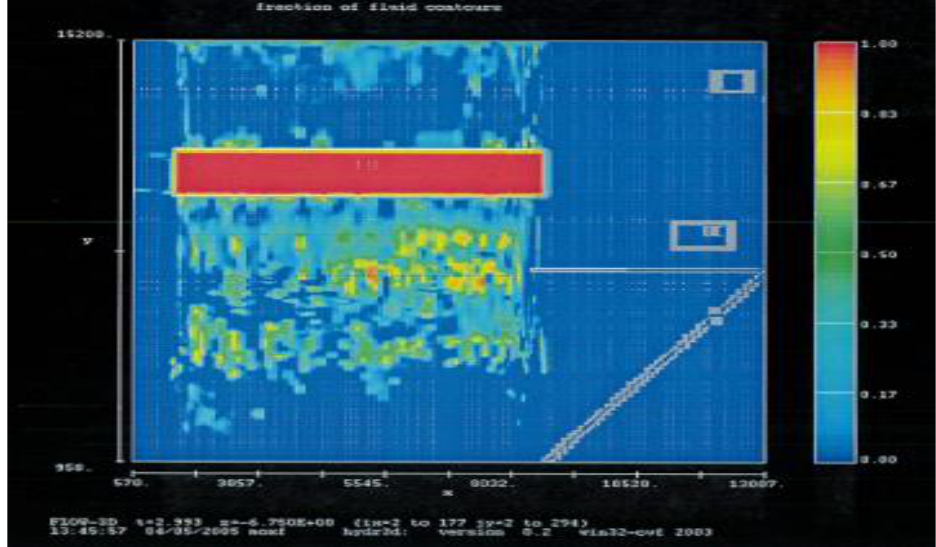
Figure 20. Aquifer fraction of fluid ff concentration at 6.75 m below the southern farm area several months into the monsoon season. Color version added to [1], p. 367.